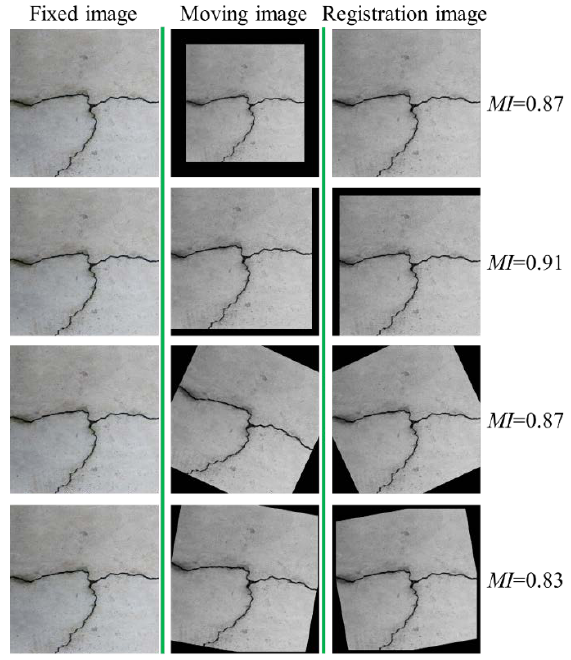
Figure 6. Image registration results of the cracks.